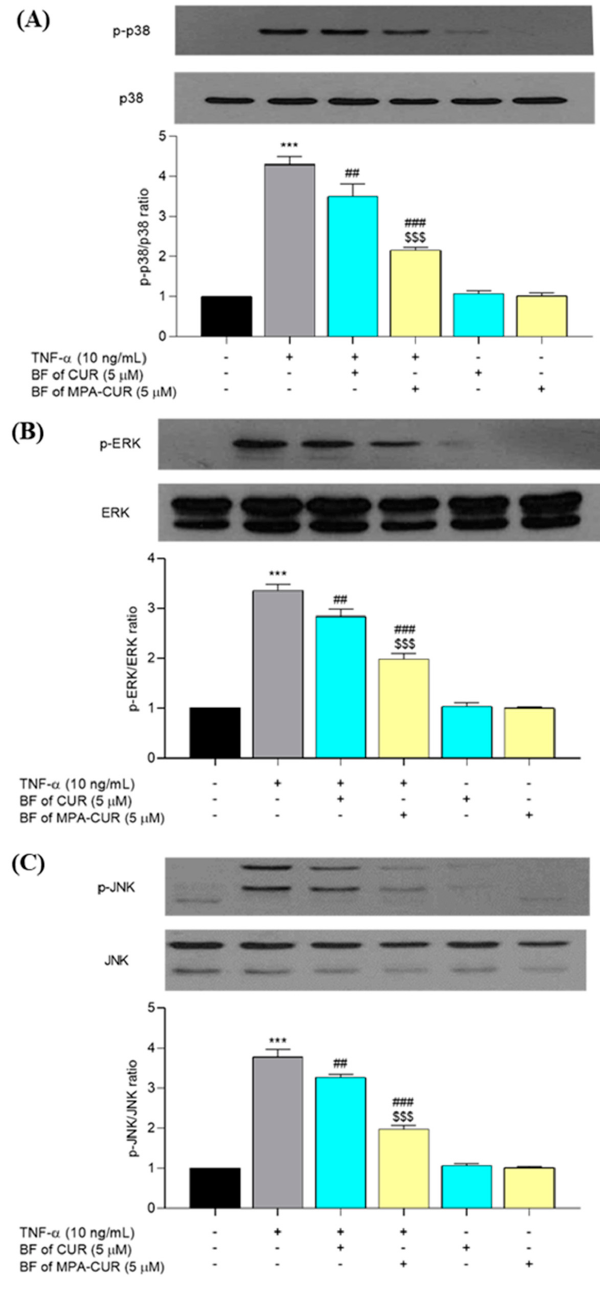
Figure 7. The effects of the BF of MPA-CUR on MAPK signaling pathway, following treatment with TNF- α in HaCaT cells. The protein expression levels of p-p38, p38, p-ERK, ERK, p-JNK, and JNK in HaCaT cells were detected by Western blot analysis ( A – C ). Data presented are mean ± SD values of three replicates *** p < 0.001 indicates significance from the untreated control cells, ## p < 0.01 and ### p < 0.001 indicates significance from the TNF- α control group and $$$ p < 0.001 indicates significance from BF of CUR treated group.